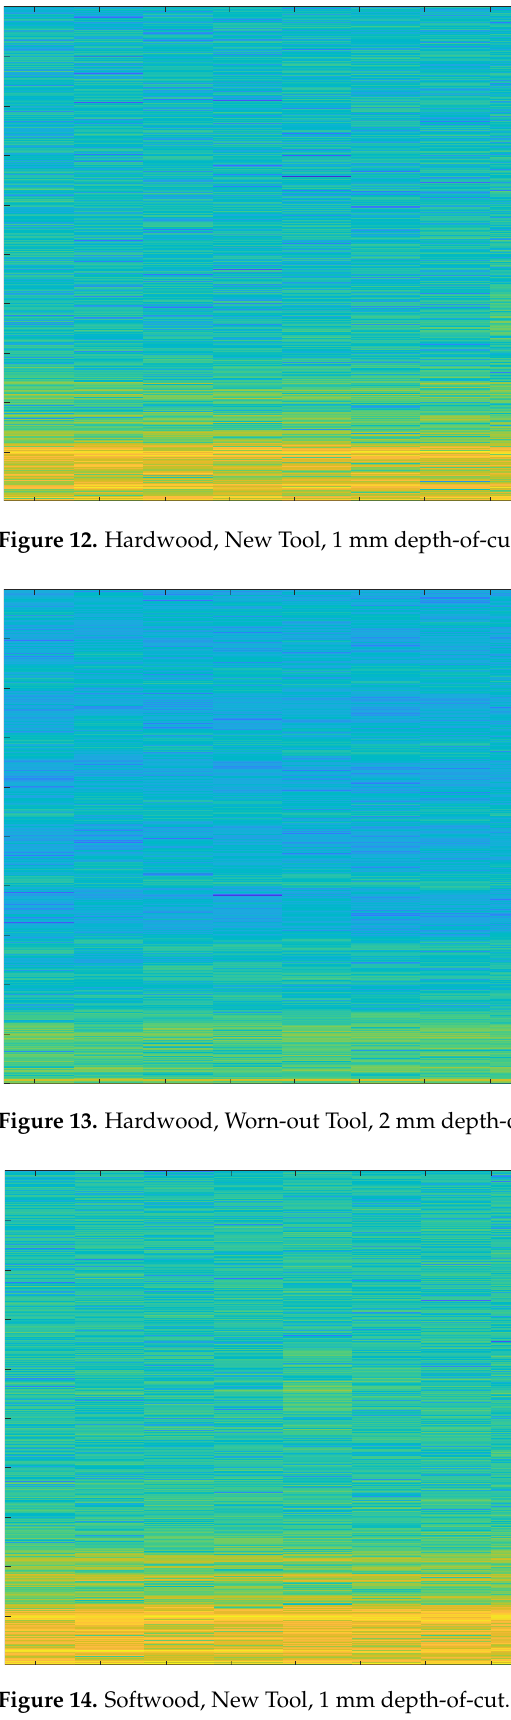
Figure 14. Softwood, New Tool, 1 mm depth-of-cut.